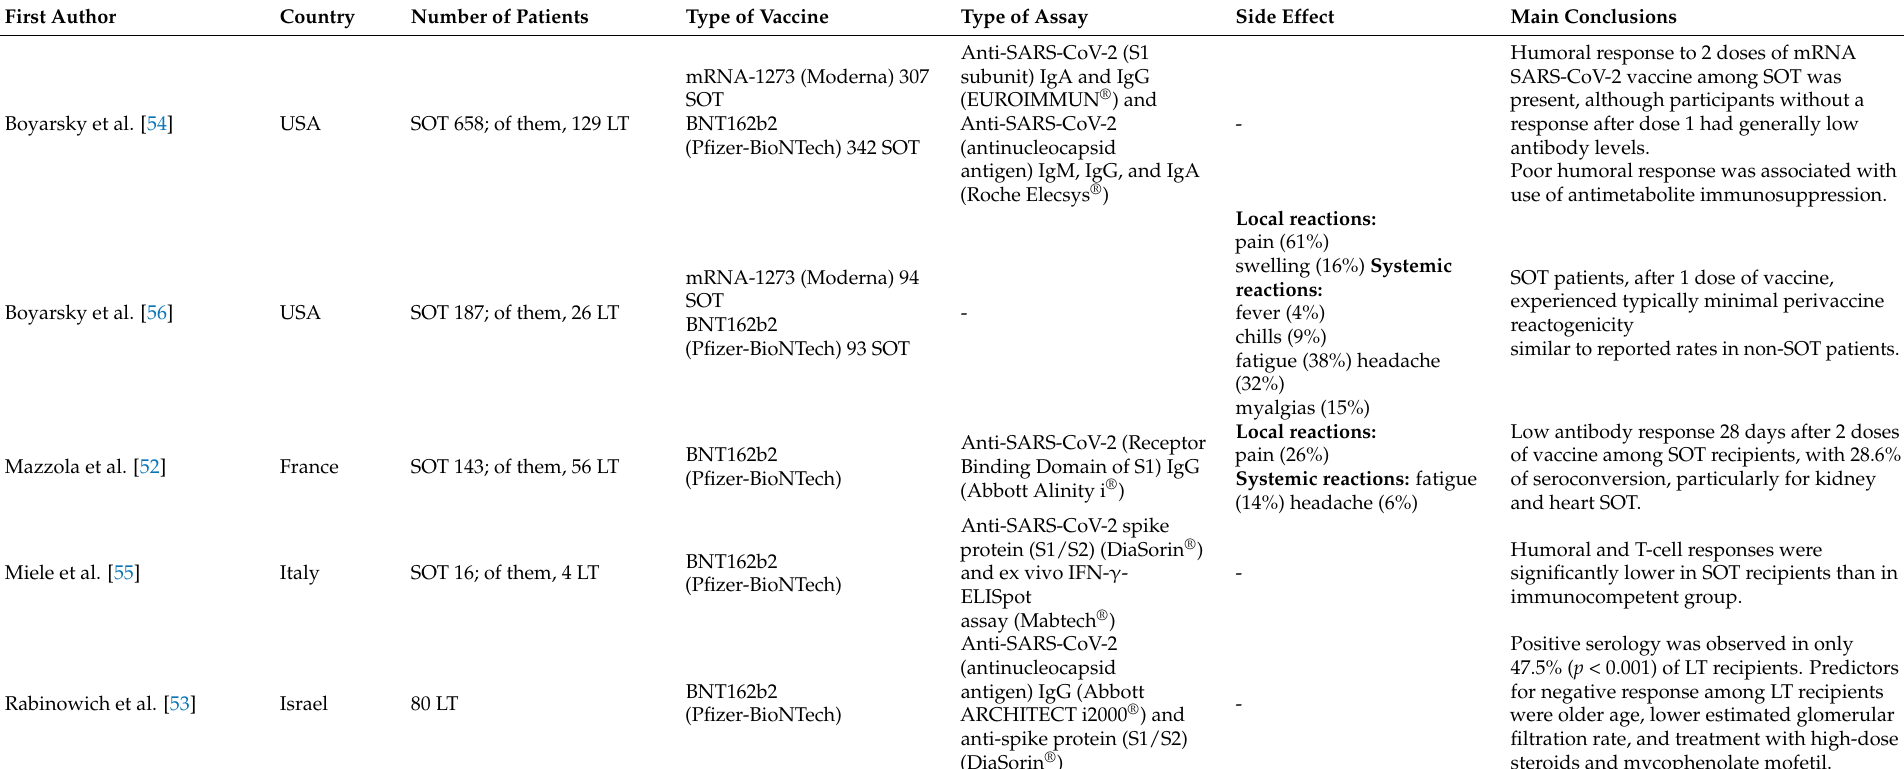
Table 4. Summary of the included study concerning vaccination against SARS-CoV-2 response in LT